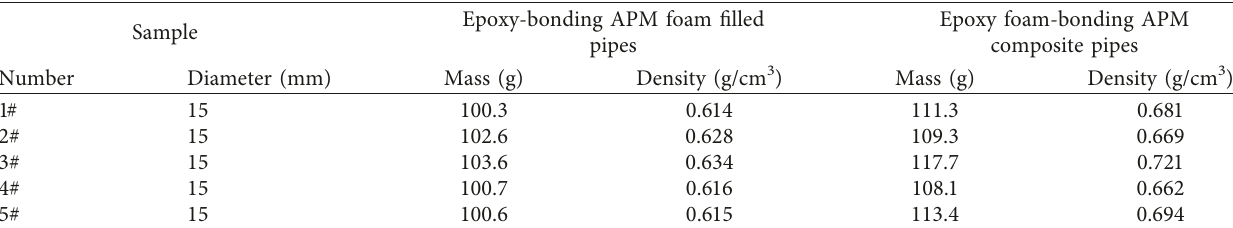
Table 1: Parameters and physical properties of the